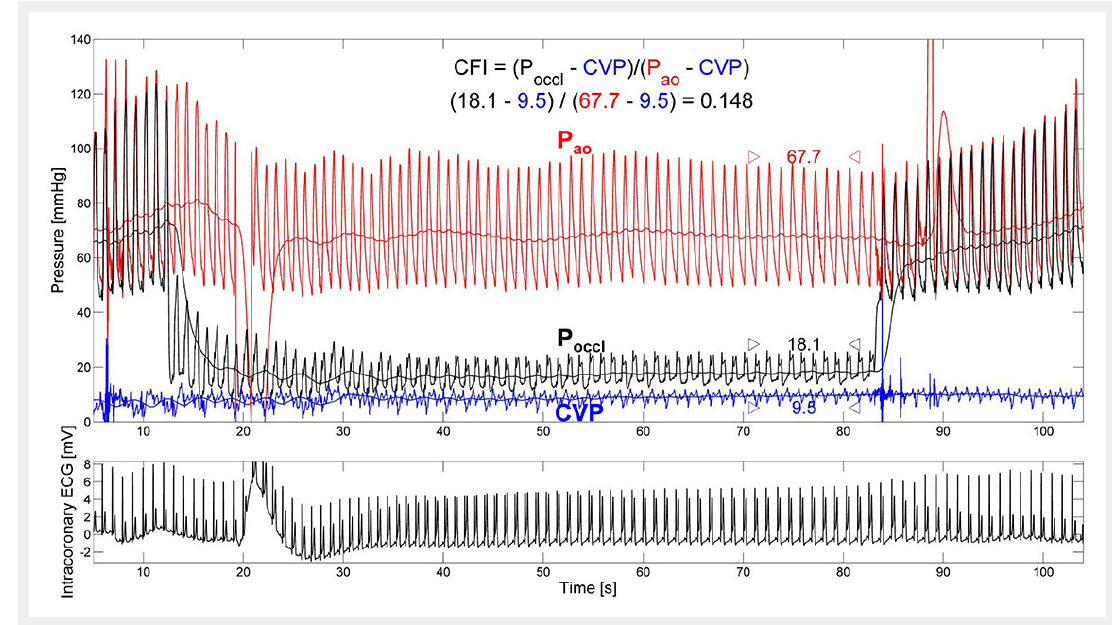
Figure 5 Functional collateral assessment by use of pressure-derived collateral flow index (CFI) during a 1-minute coronary balloon occlusion. Distal occlusive pressure (P occl , mm Hg;) is set in relation to the effective perfusion pressure, aortic pressure (P ao , mm Hg;), after correction for the back pressure, central venous pressure (CVP, mm Hg;). Marked ST-segment elevation in the intracoronary ECG demonstrates collateral function insufficient to prevent myocardial ischaemia at a CFI = 0.148. (Reproduced from Seiler C, et al. Prognostic relevance of coronary collateral function: confounded or causal relationship? Heart. 2013;99(19):1408-14 [5], with permission from BMJ Publication Group